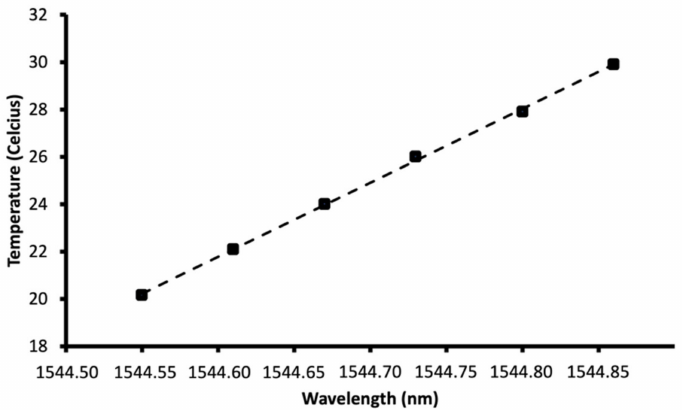
Figure 6. Measured temperature response of the Bragg wavelength of a FBG